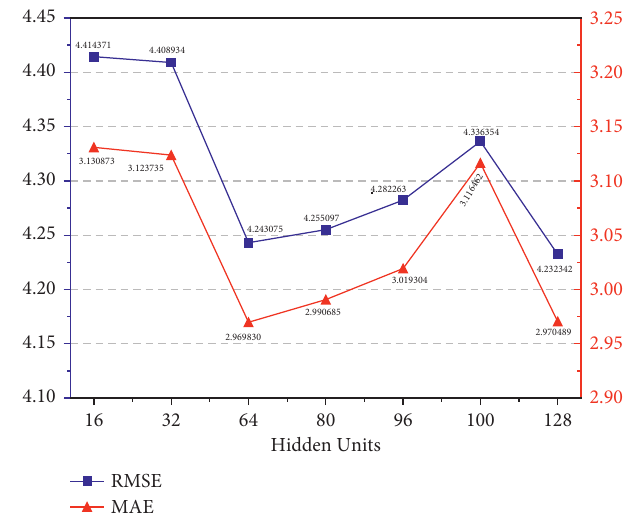
Figure 7: RMSE and MAE change with the number of hidden